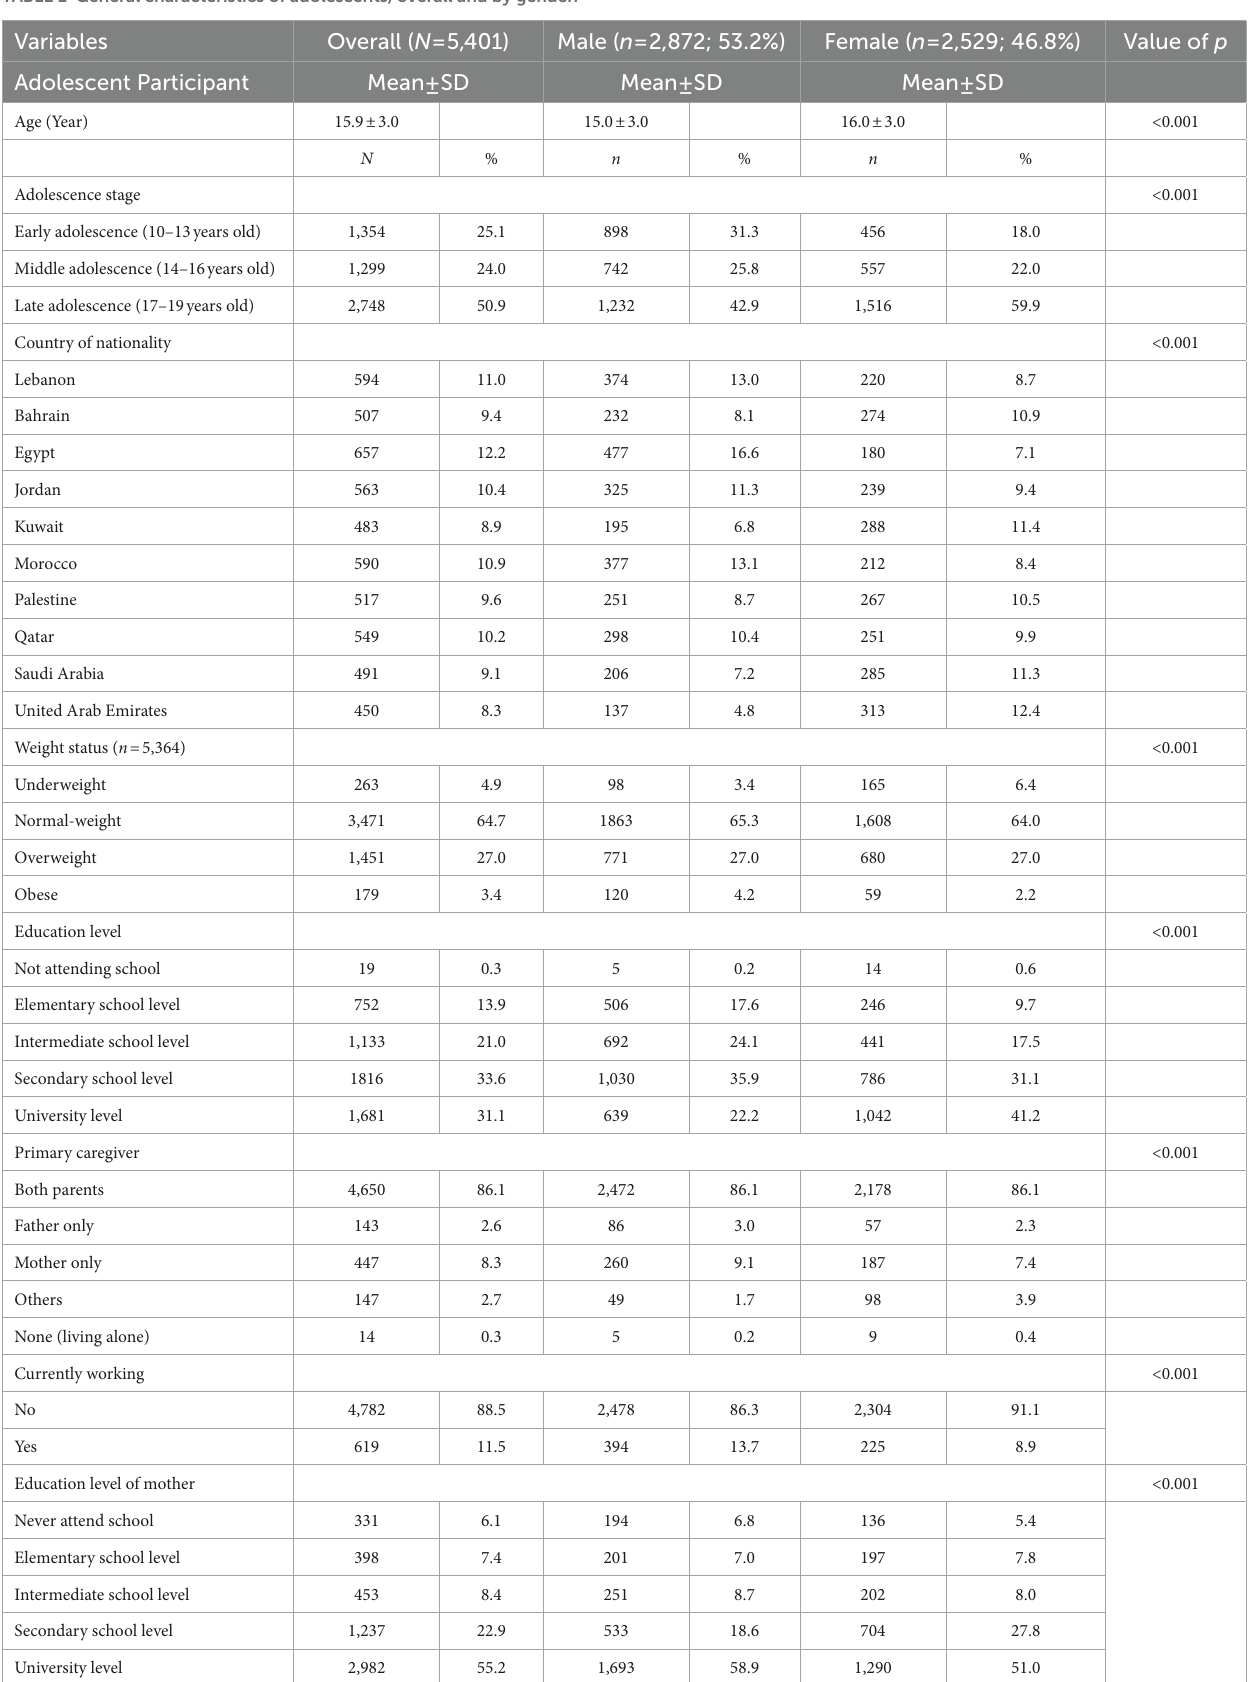
TABLE 1 General characteristics of adolescents, overall and by gender.